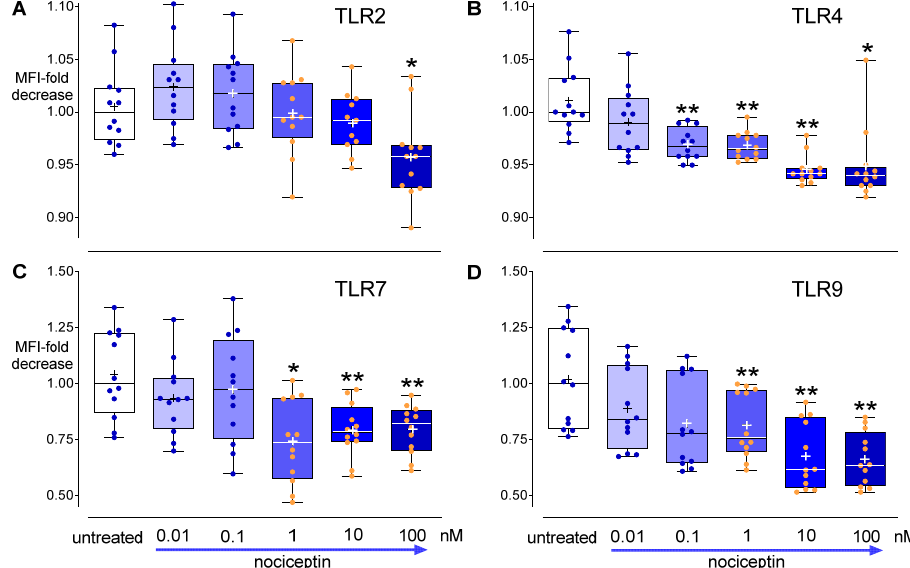
Figure 8. Effects of nociceptin on TLR protein levels in THP ‐ 1 cells. Cells were cultured with or without different concentrations of exogenous nociceptin (0.01–100 nM) for 24 h. Flow cytometric analysis of cell surface TLR2 ( A ), TLR4 ( B ), and intracellular TLR7 ( C ) and TLR9 protein levels ( D ). Flow cytometry data are presented as mean fluorescence intensity (MFI) related to the corresponding untreated groups (controls). Boxplots with individual data points, median, IQR, and mean “+”; n = 12. Wilcoxon test with correction for multiple testing. *, p < 0.05; **, p < 0.01, compared to the respective